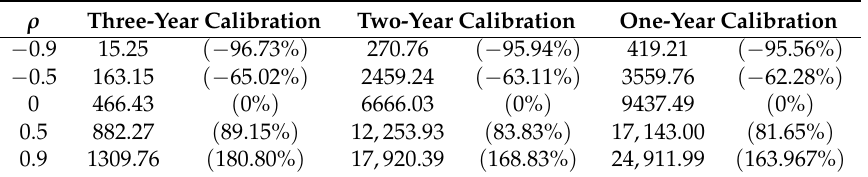
Table 5. Quanto option